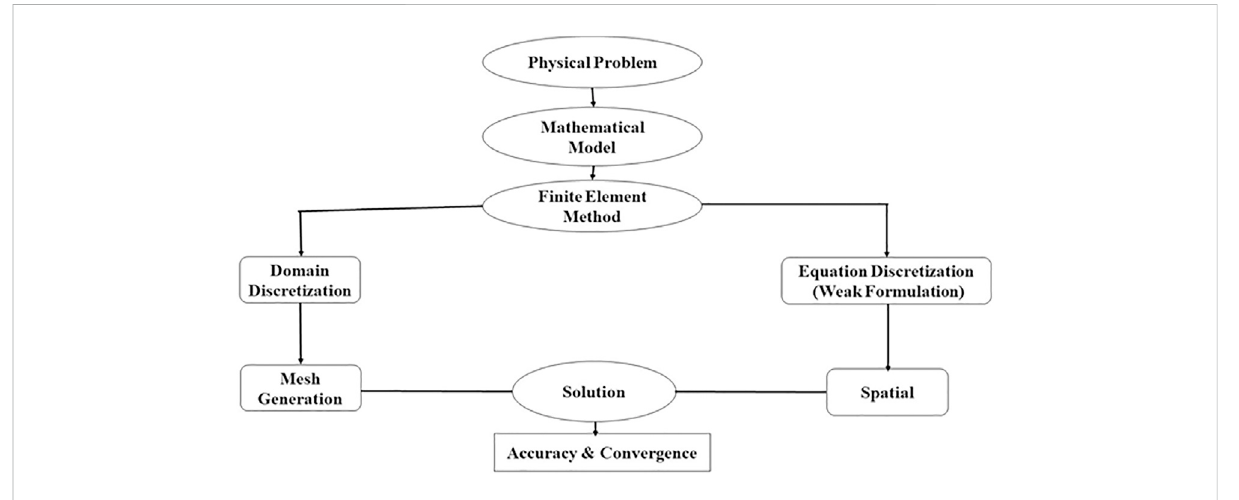
FIGURE 3 Schematic diagram of the fi nite element method.